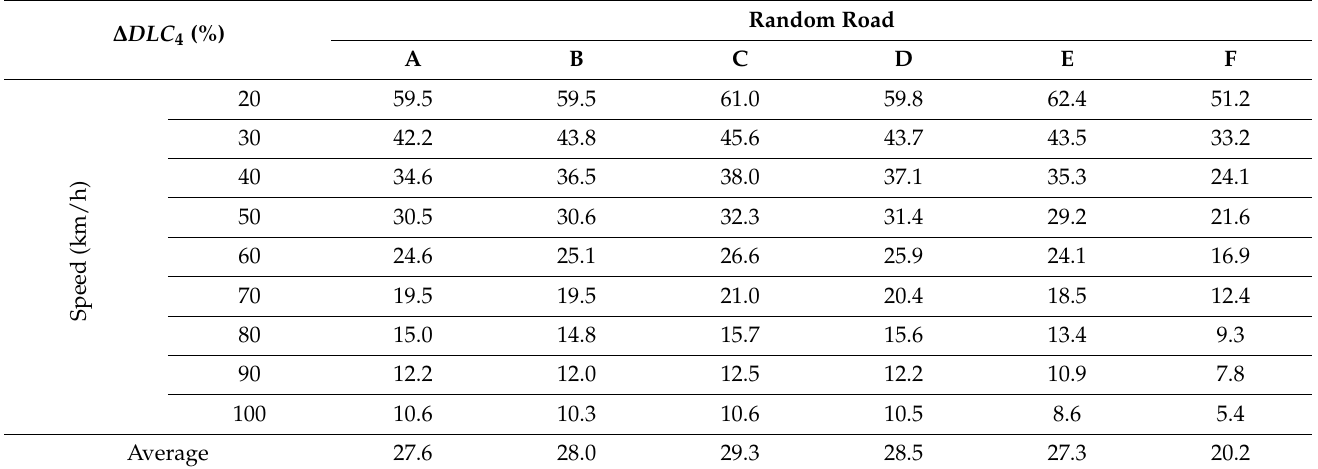
Table 4. The extent of the reduction of ∆ DLC (%): 4th axle.